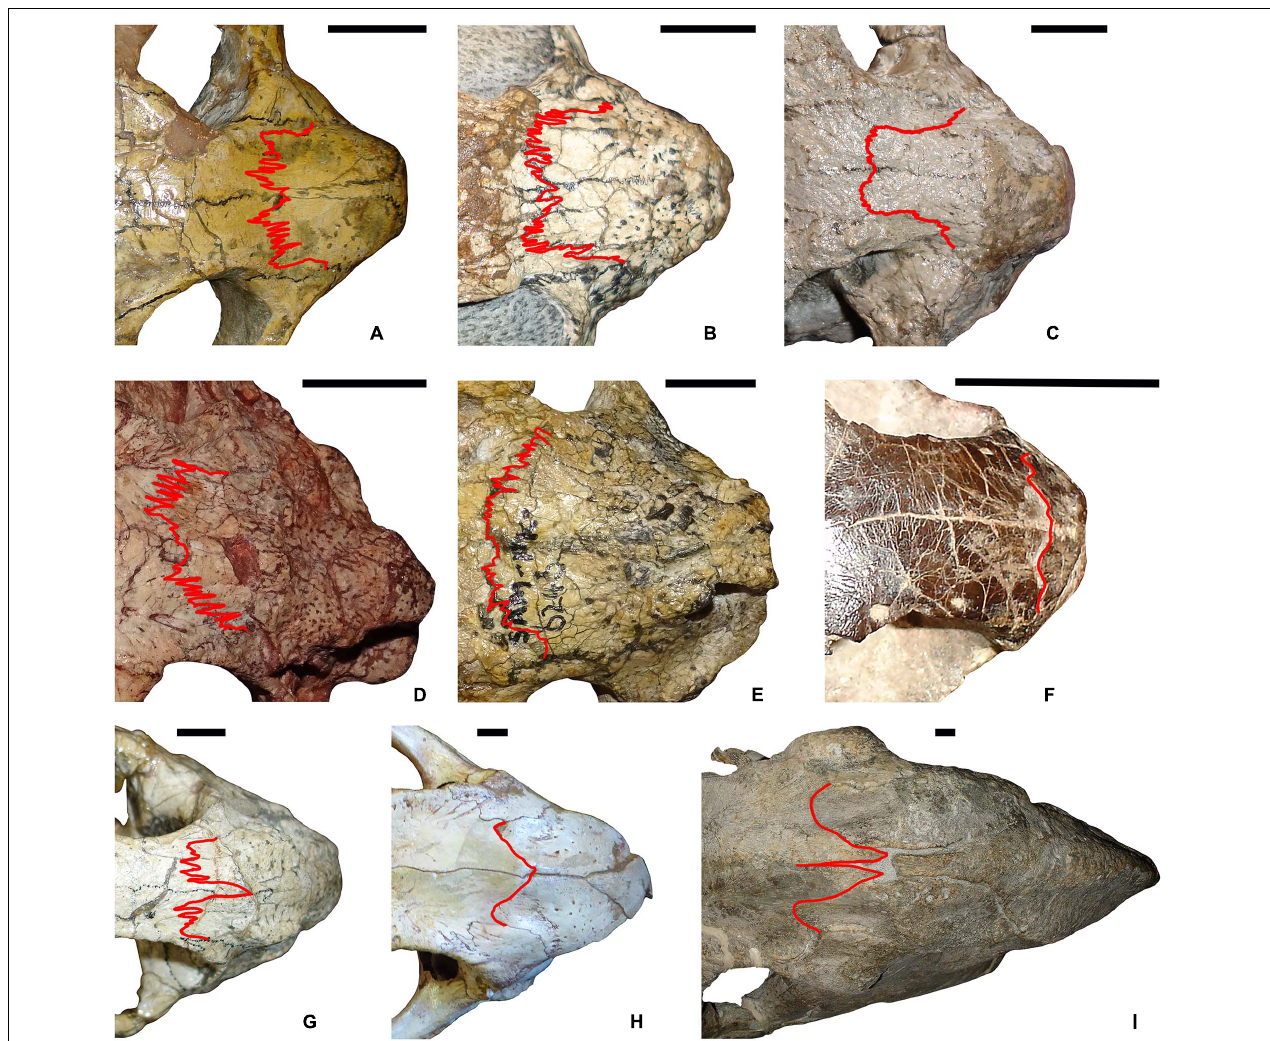
FIGURE 3 | Comparison of naso-frontal sutures (highlighted in red) in select dicynodonts. (A) Cistecephalus microrhinus (BP/1/33). (B) Cistecephalus microrhinus (CGS R30). (C) Cistecephalus microrhinus , aberrant specimen (CGS RMS410). (D) Kembawacela kitchingi (NHCC LB14). (E) Cistecephaloides boonstrai (SAM-PK-6243). (F) Myosaurus gracilis (BP/1/4262). (G) Diictodon feliceps (SAM-PK-K7730). (H) Delectosaurus arefjevi (PIN 4644/1). (I) Dinanomodon gilli (SAM-PK-K10618). Specimens in (A–E) are cistecephalids (inferred to be fossorial). (F) is a member of the sister-clade to Cistecephalidae (Myosauridae), whose ecology is uncertain. (G) is a known burrower (skeletons found in burrow casts), but lacks specializations indicating that it was primarily fossorial in ecology. (H) and (I) are large, presumed fully surface-dwelling taxa. Scale bars represent 1